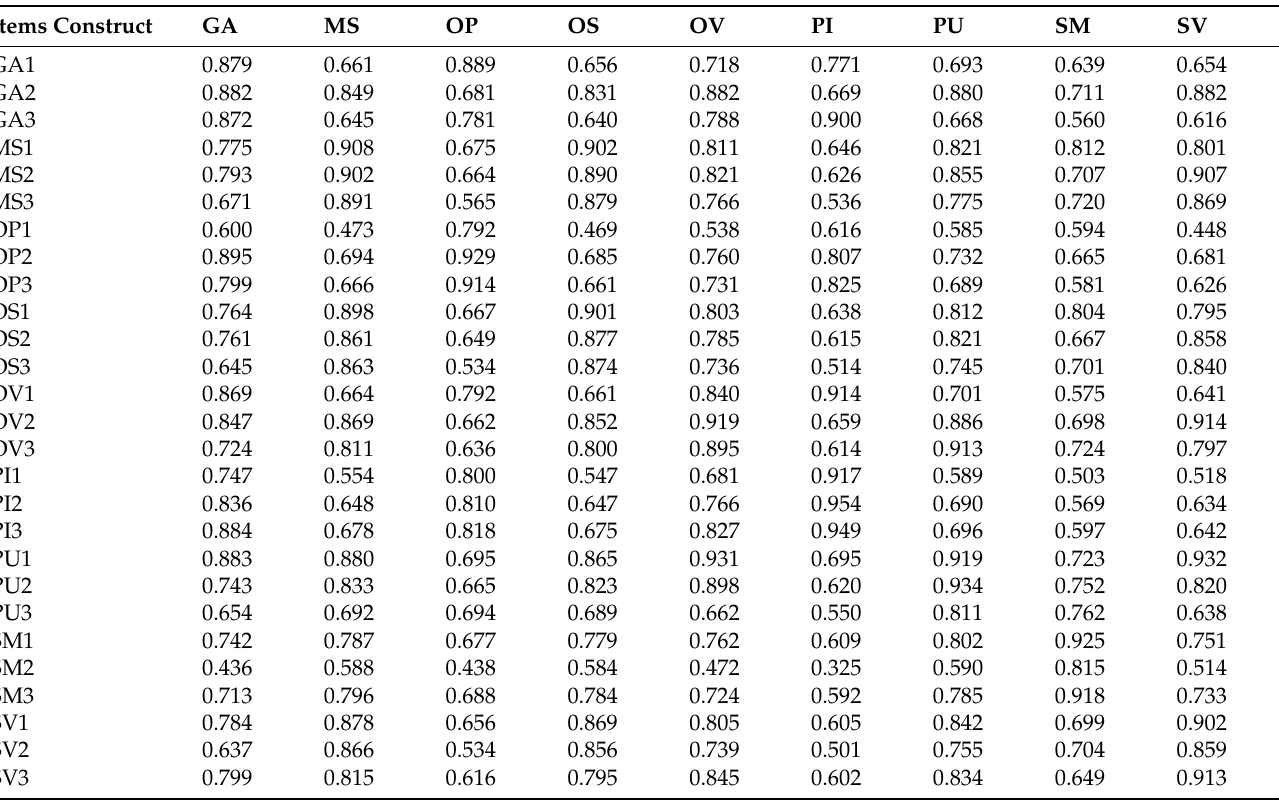
Table 5. Factor loadings and cross-loadings.